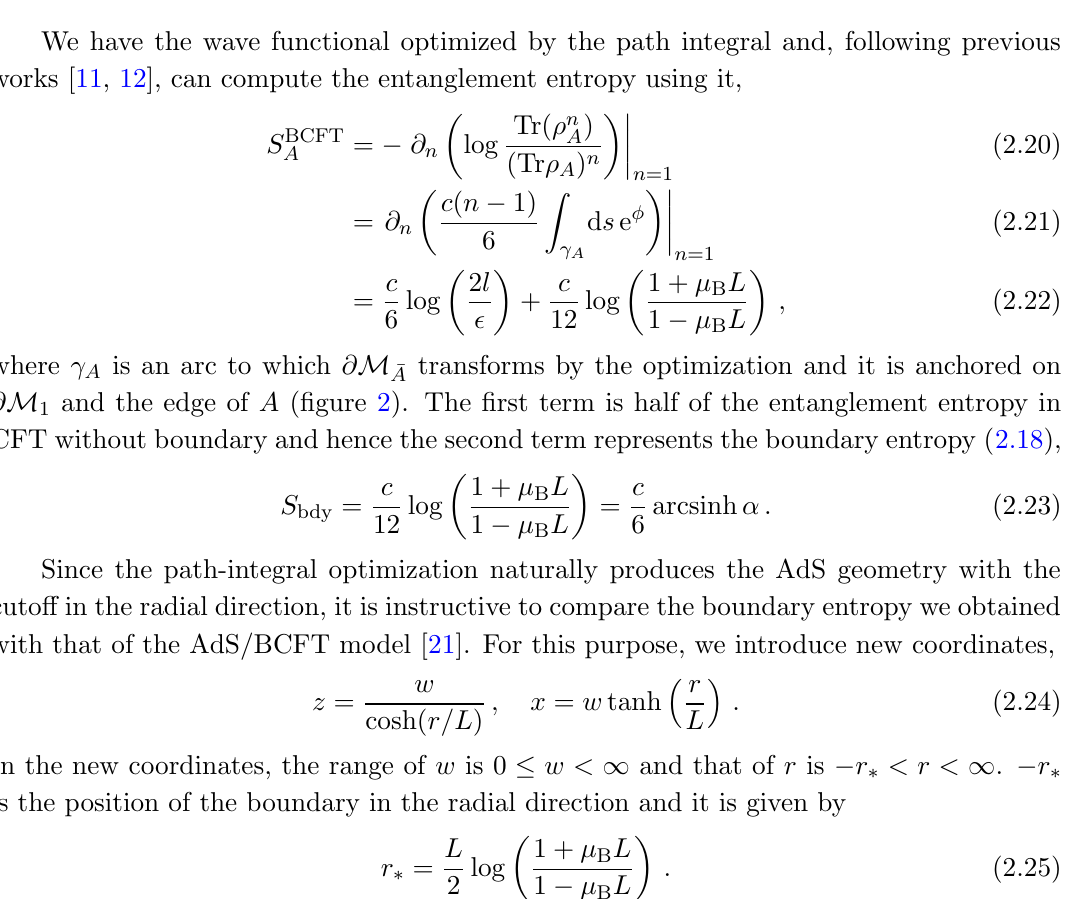
Figure 2 . The entanglement entropy associated to the subsystem A (0 (cid:20) x (cid:20) l ) is given by the length of the arc (cid:13) A anchored on the boundary surface @ M 1 ( x = (cid:0) (cid:11)z ) and the edge of A